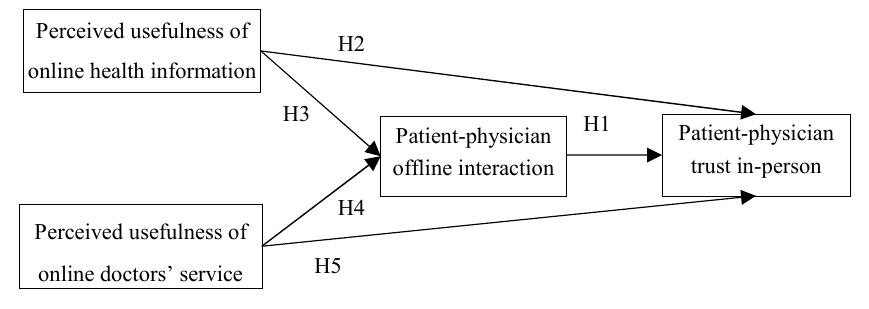
Figure 1. Research Figure 1. Research model.